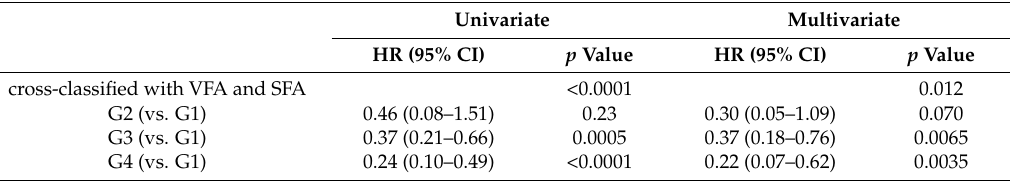
Table 3. Coxproportionalhazardsanalysisoftheriskofall-causemortalityinpatientsundergoinghemodialysis. Univariate Multivariate HR (95% CI) p Value HR (95% CI) p